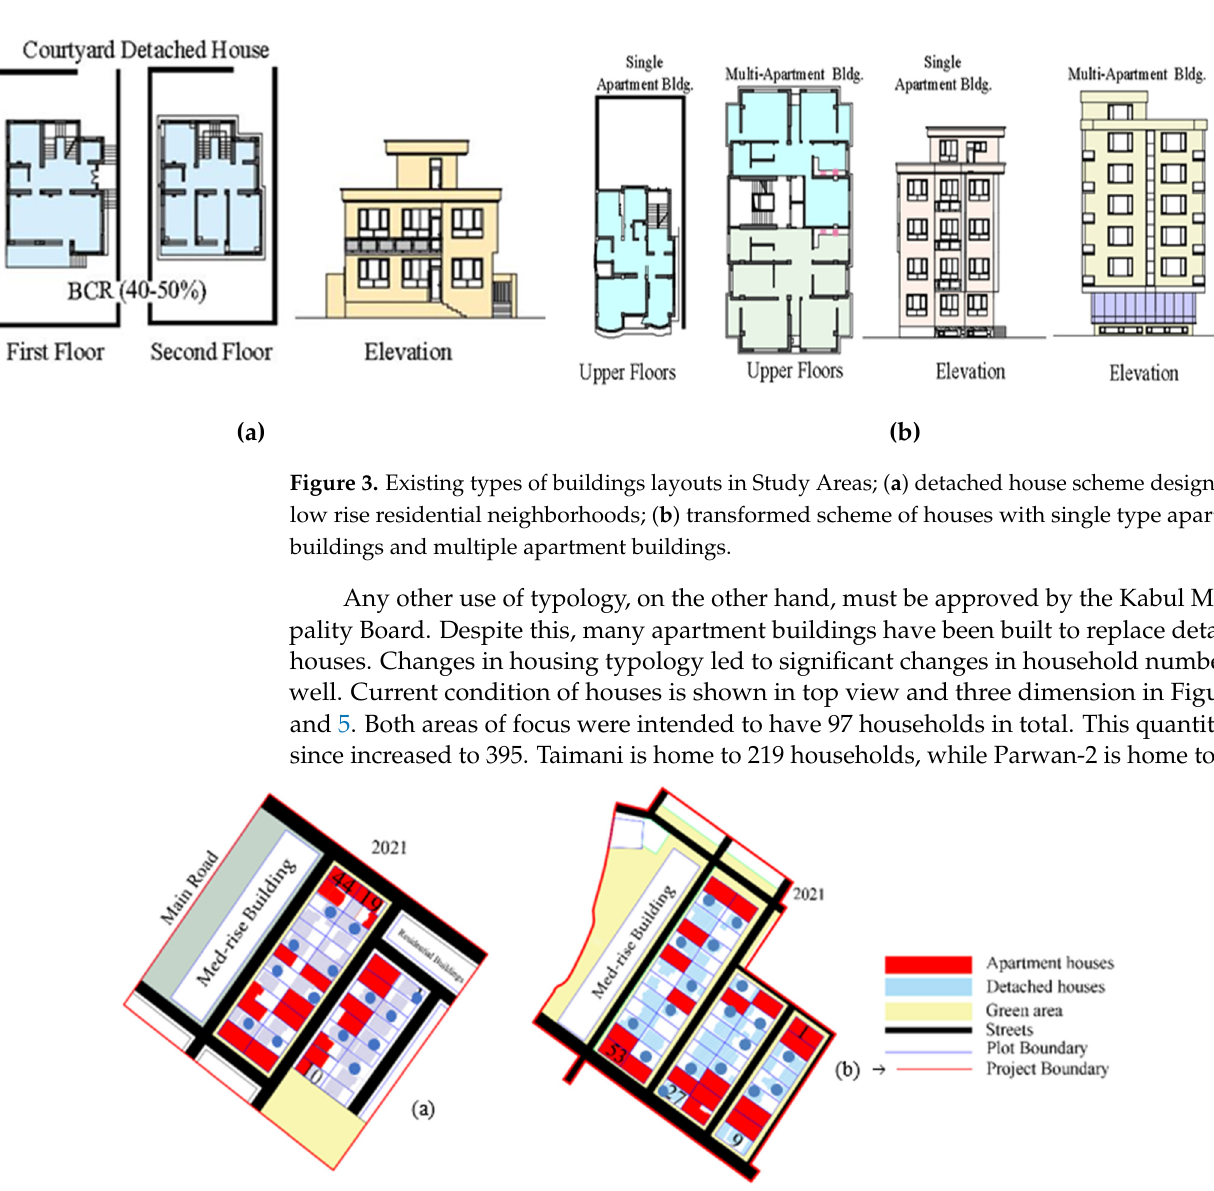
Figure 4. Current Condition of Study Areas and Surveyed Houses: ( a ) Parwan-2; ( b ) Taimani.